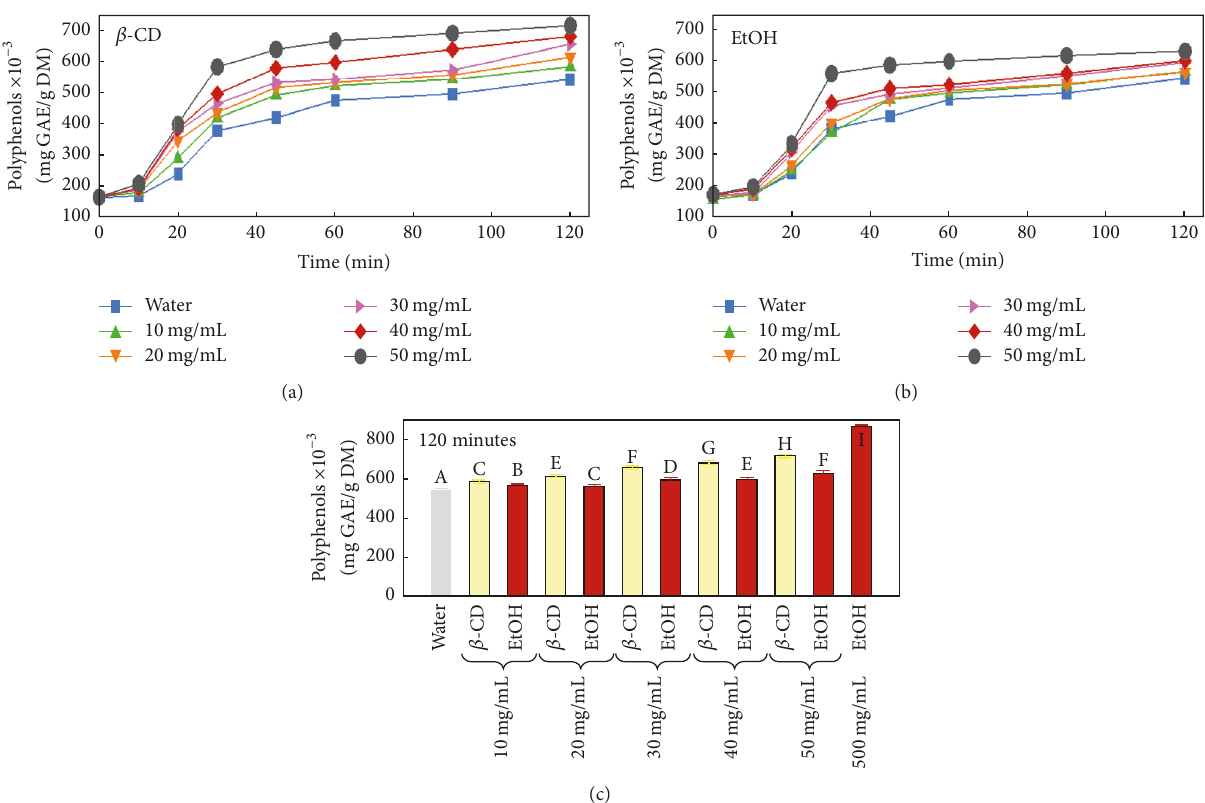
Figure 1: (a) Extraction kinetics of polyphenols with different concentrations (0, 10, 20, 30, 40, and 50 mg/mL) of beta-cyclodextrin ( 𝛽 - CD) and (b) different concentrations (0, 10, 20, 30, 40, and 50mg/mL) of ethanol (EtOH). (c) Comparison of polyphenol recovery with both solvents ( 𝛽 -CD and EtOH) at the same concentrations after 120 minutes of extraction. Different superscript letters indicate significant statistical difference ( 𝑝 < 0.05